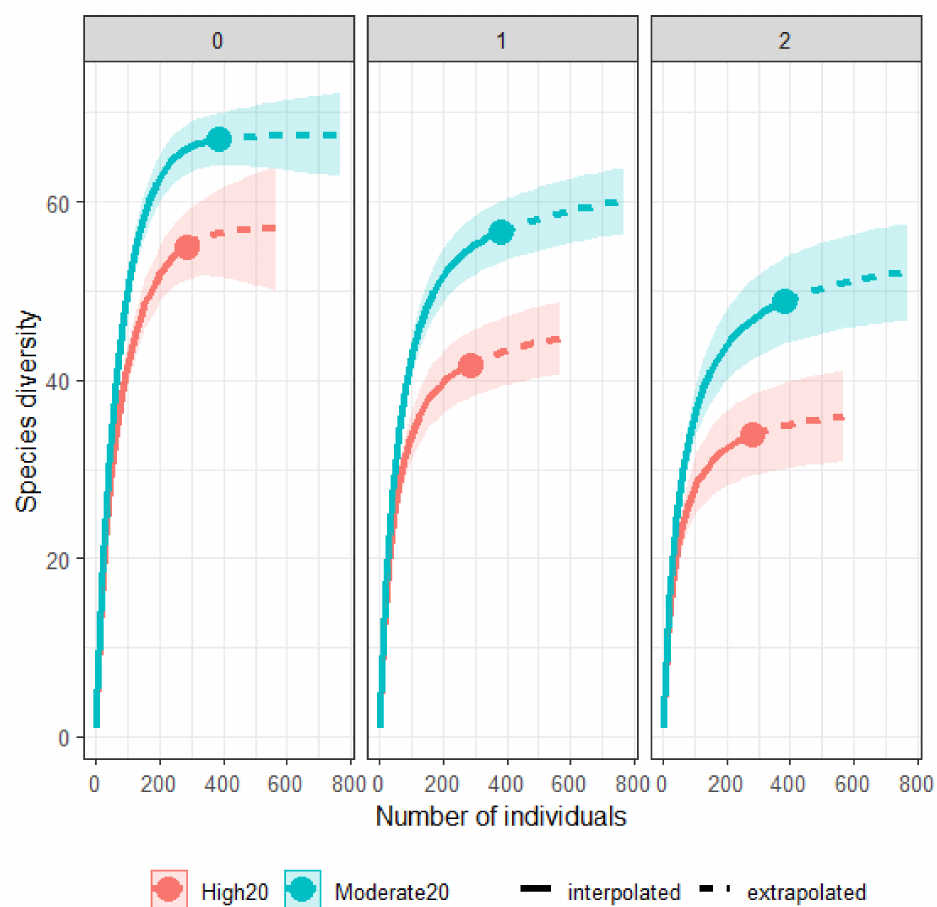
Figure 9. Comparison of tree species biodiversity between high and moderate utilization regimes after 20 years of abandonment based on Hill numbers for different orders (0, 1, and 2). The solid and dotted lines represent the rarefaction and extrapolation curves, respectively. The shaded area indicates the confidence interval at 95%, based on bootstrap method with 200